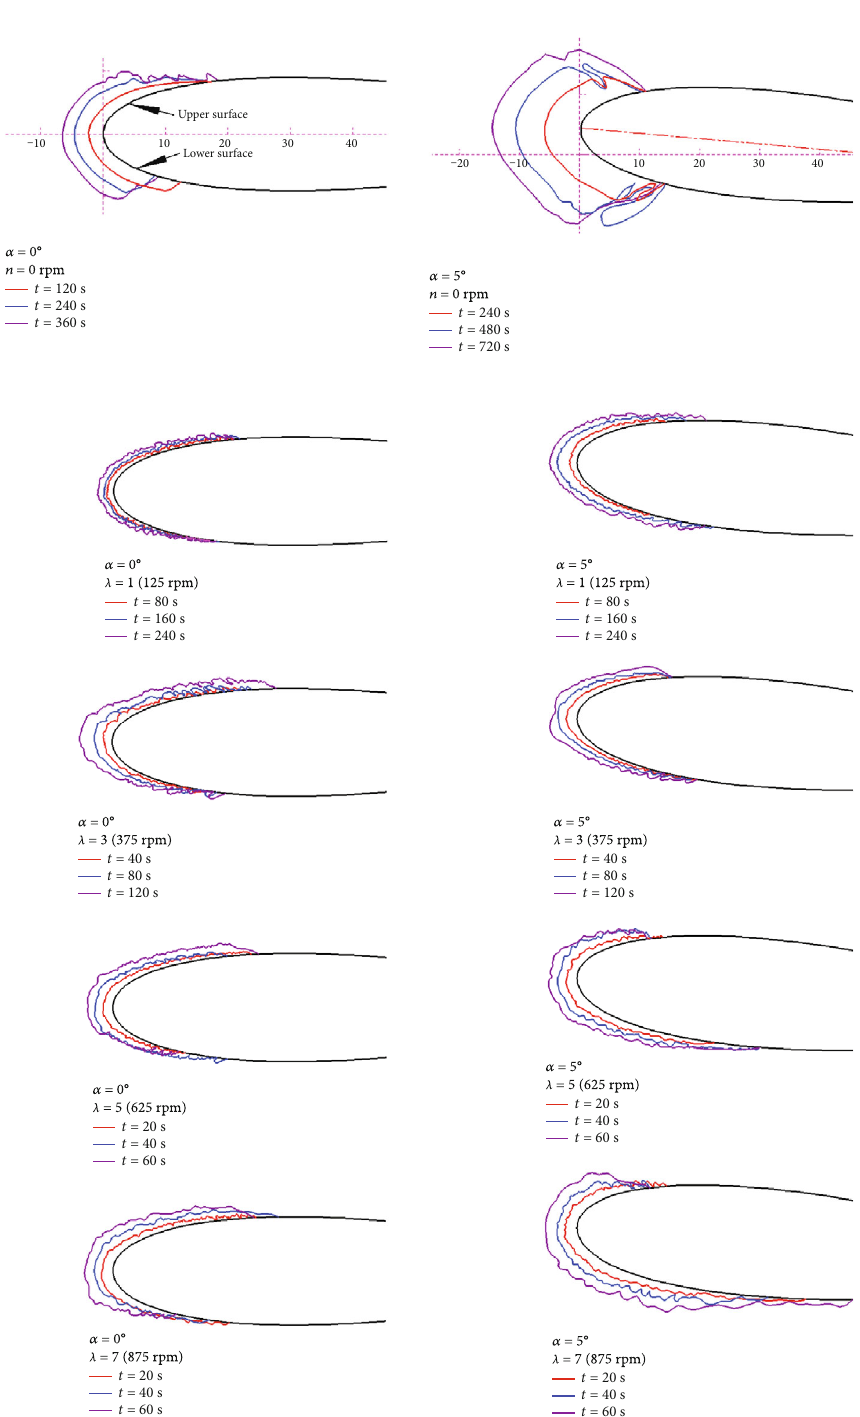
Figure 16: Icing shapes and distributions under di ff erent